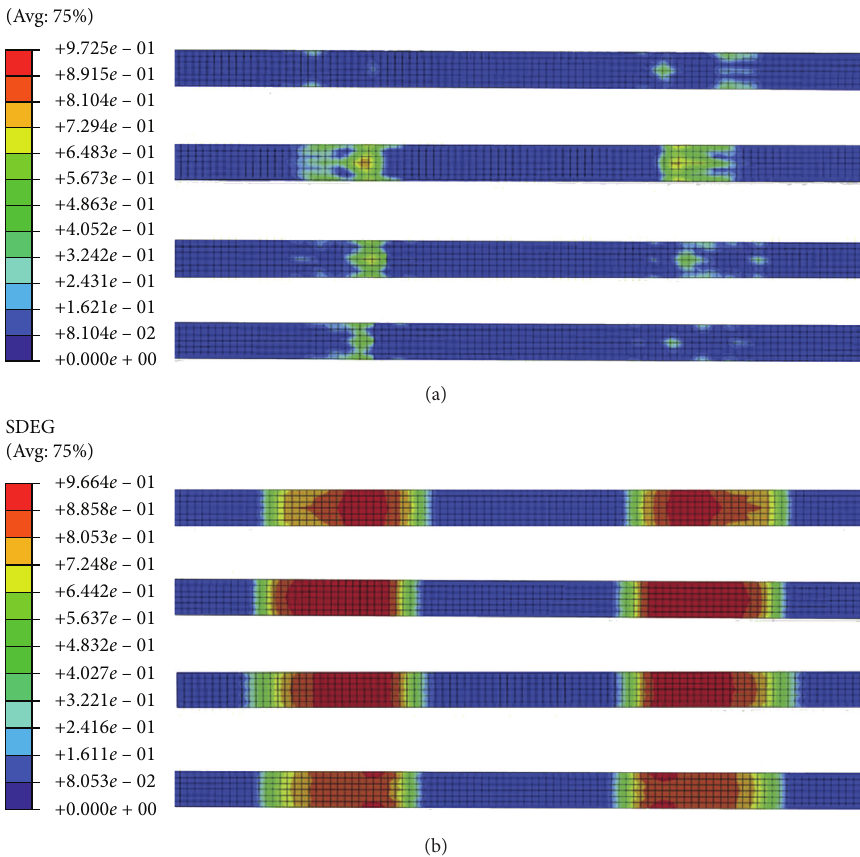
Figure 6: SDEG distribution of C-ITZ at the ultimate load state. (a) B1-1, B2-1, B3-1, and B4-1. (b) B1-2, B2-2, B3-2, and